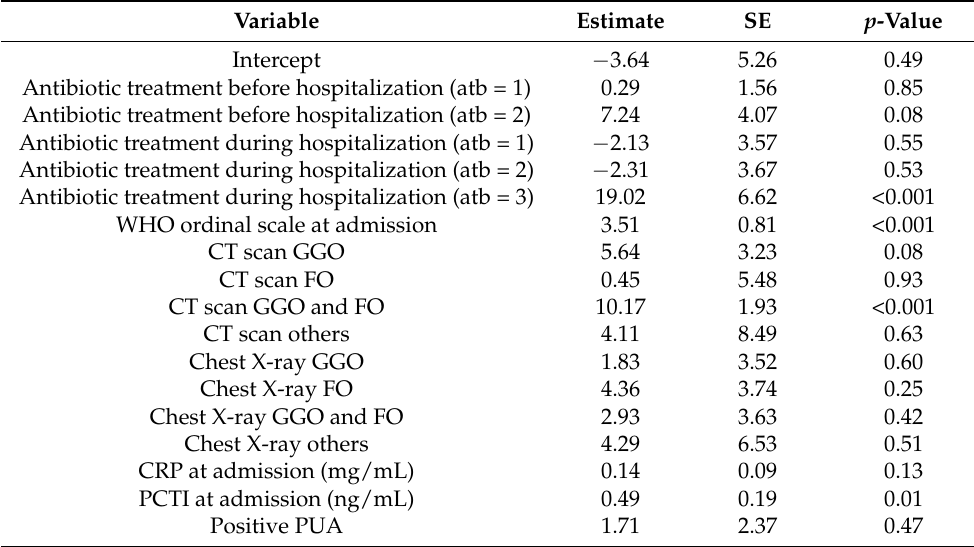
Table 3. Multivariate linear regression for length of stay. Variable